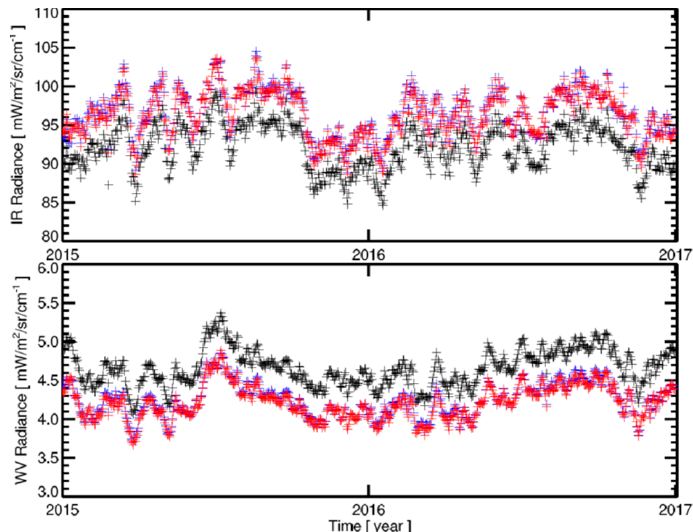
Figure 9. Comparison of operational calibrated (black), GSICS corrected (blue) and recalibrated (red) radiances for IR (top) and WV (bottom) channel measurements (see text for details). Measurements from noon images with viewing zenith angles less than 60 degree were used in this figure.